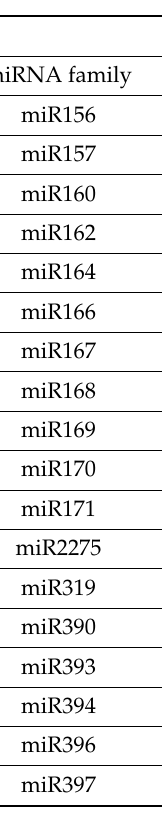
Table 1. MicroRNA families identified in J. regia and J. microcarpa.